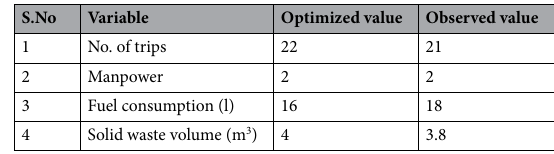
Table 2. Predicted and observed values.